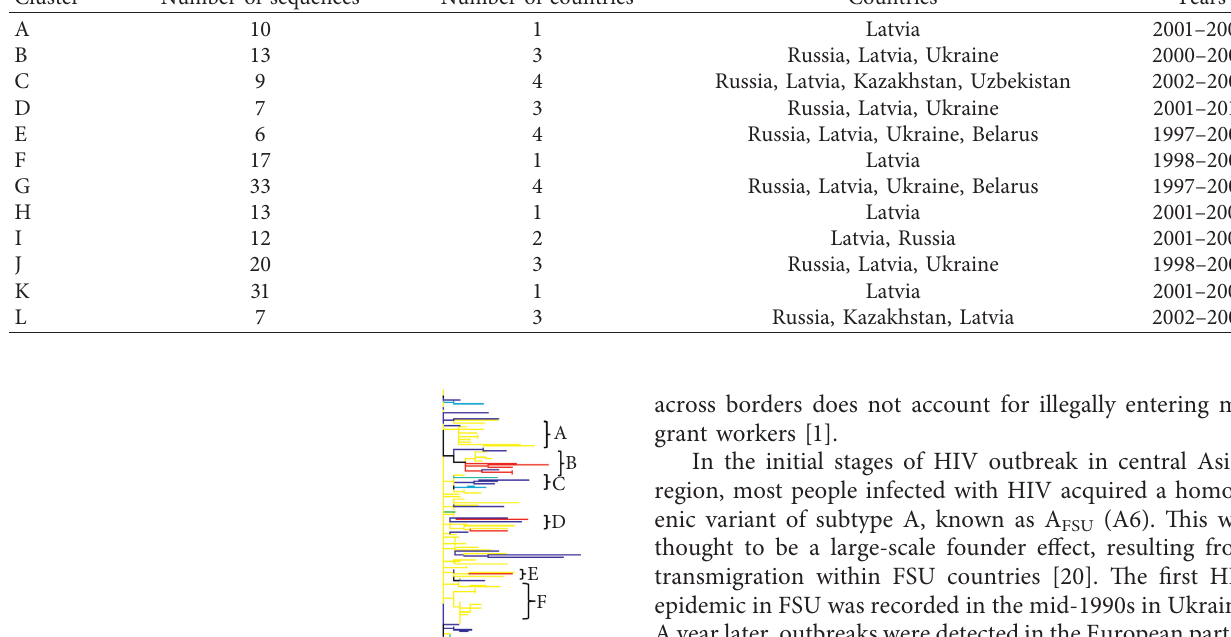
Table 4: Cluster analysis of HIV gag tree in Figure 4 showing distribution of sequences among FSU countries. Cluster